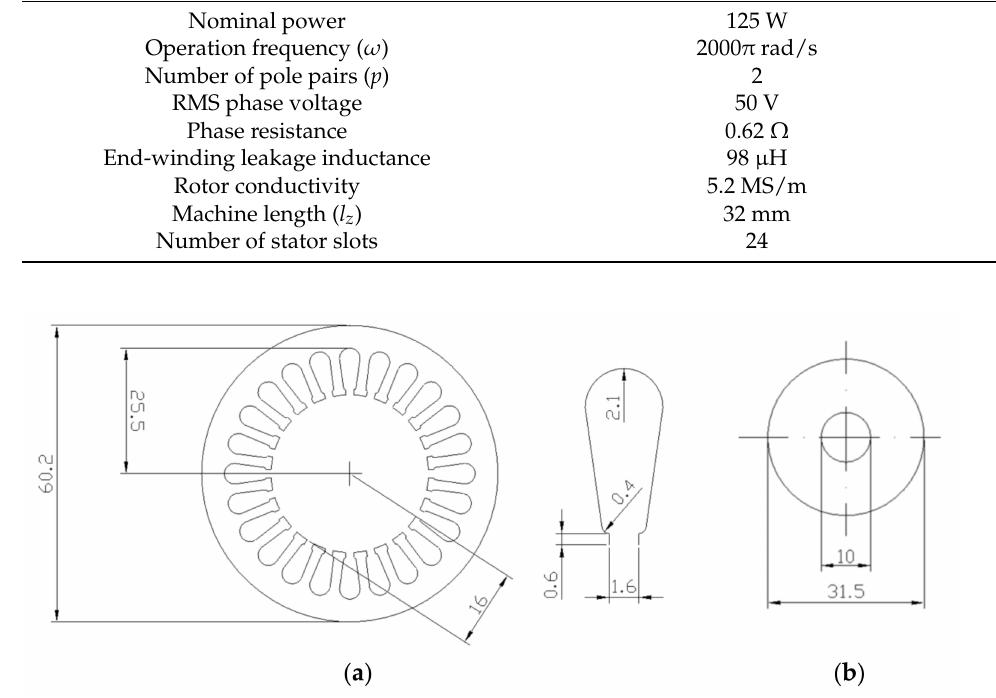
Figure 1. Solid rotor induction machine taking into consideration: ( a ) dimensions of the stator package (cross-section area), ( b ) dimensions of the rotor [31].